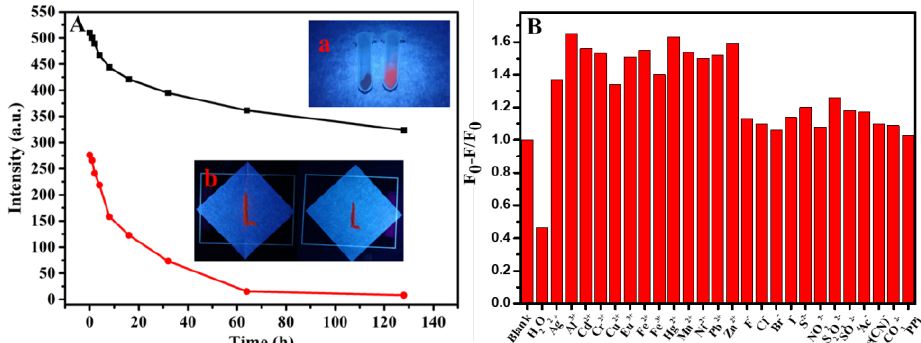
Figure 6. ( A ) The stability test of LA − Cu NCs (lower, red line) and LA − Cu NCs@CS (upper, black line), Insert: (a) Photos of the solid powder products of LA − Cu NCs (left) and LA − Cu NCs@CS (right) under UV light; (b) The photos of LA − Cu NCs@CS powder under UV light before (left) and after (right) two months. ( B ) Fluorescence responses of the fluorescence probe towards H 2 O 2 and various metal ions.